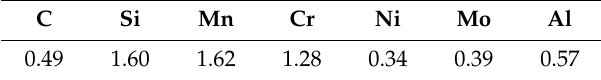
Table 1. Main chemical composition of the test steel,